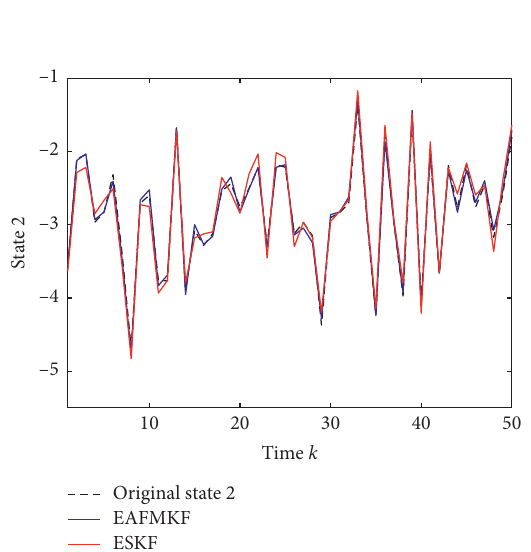
Figure 4: Estimation curve for state 2.